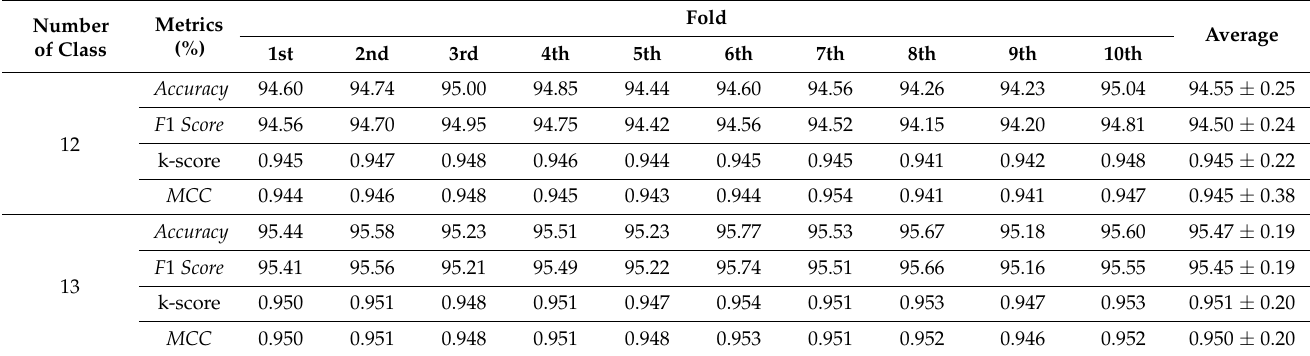
Table 3. Performance result of the proposed model on the CSI-based HHI dataset with 10-fold CV. All results are in percentages